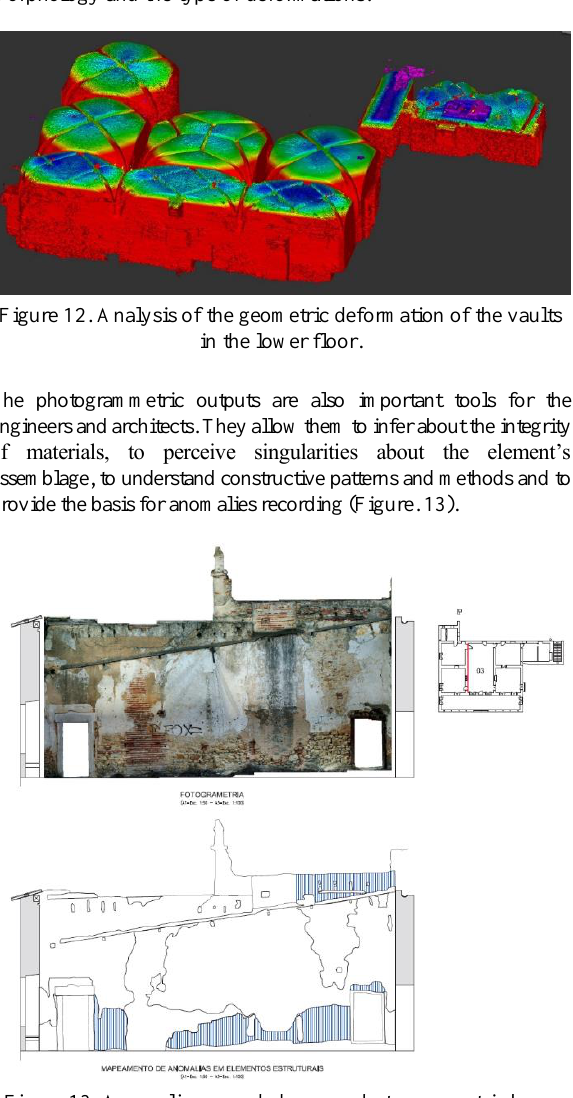
Figure 13. Anomalies recorded over a photogrammetric